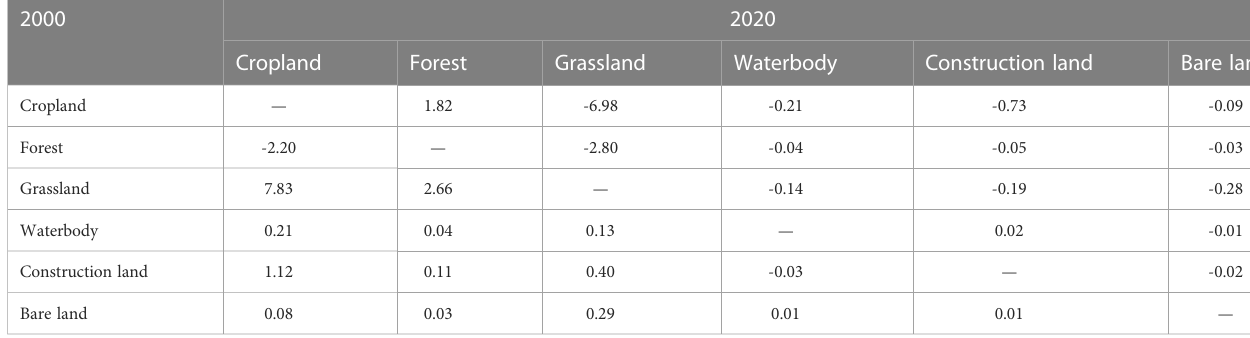
TABLE 2 The amount of NPP transferred during the change in land use types in the MRYR from 2000 to 2020